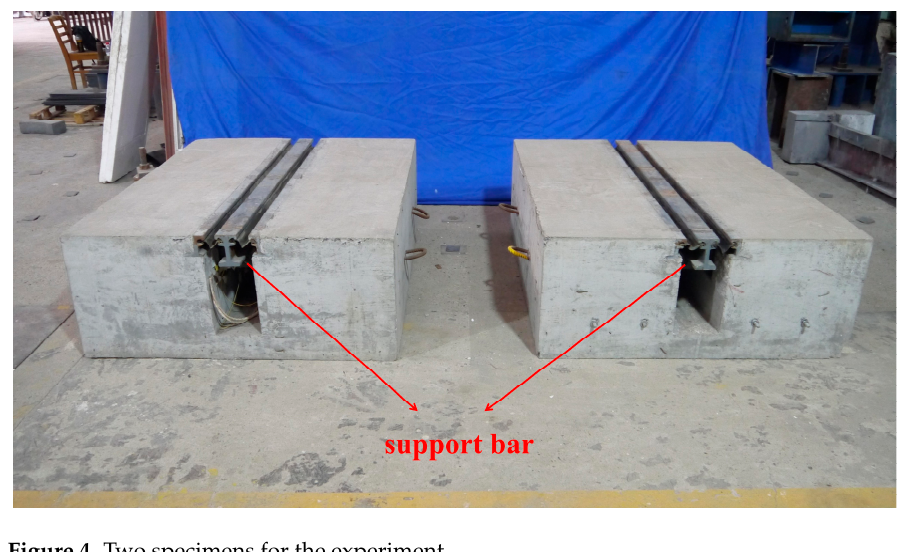
Figure 4. Two specimens for the experiment.